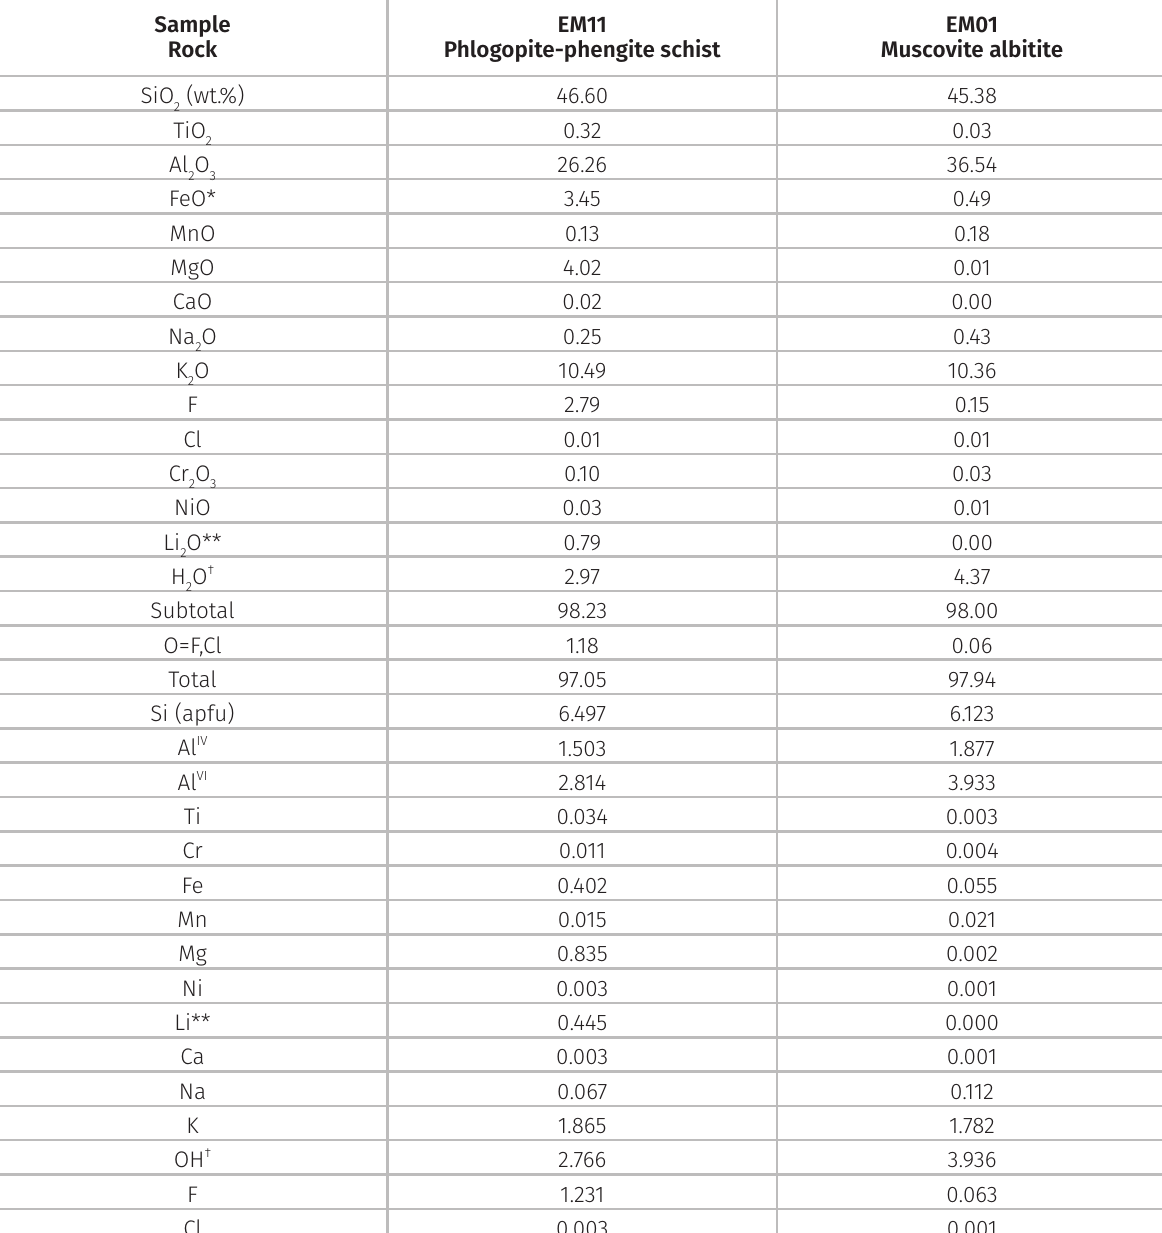
EM11 Phlogopite-phengite schist